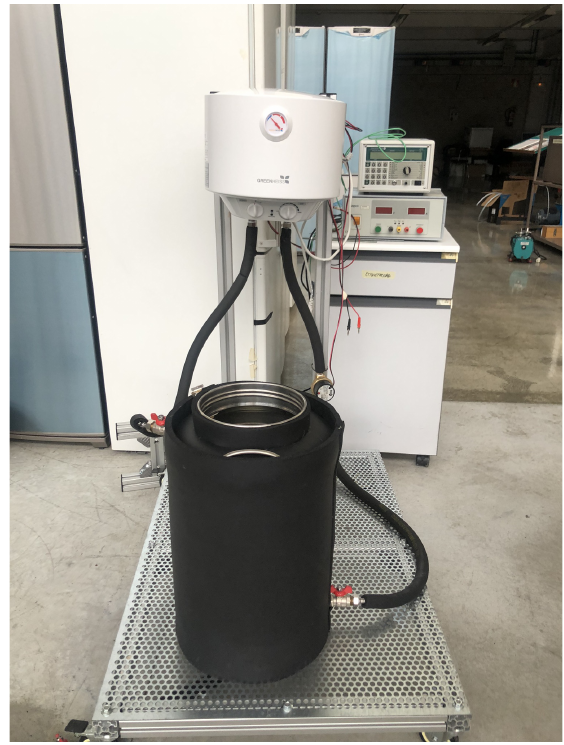
Figure 4. Thermal bath used as heat source in the laboratory experiments to determine the power generated by the designed